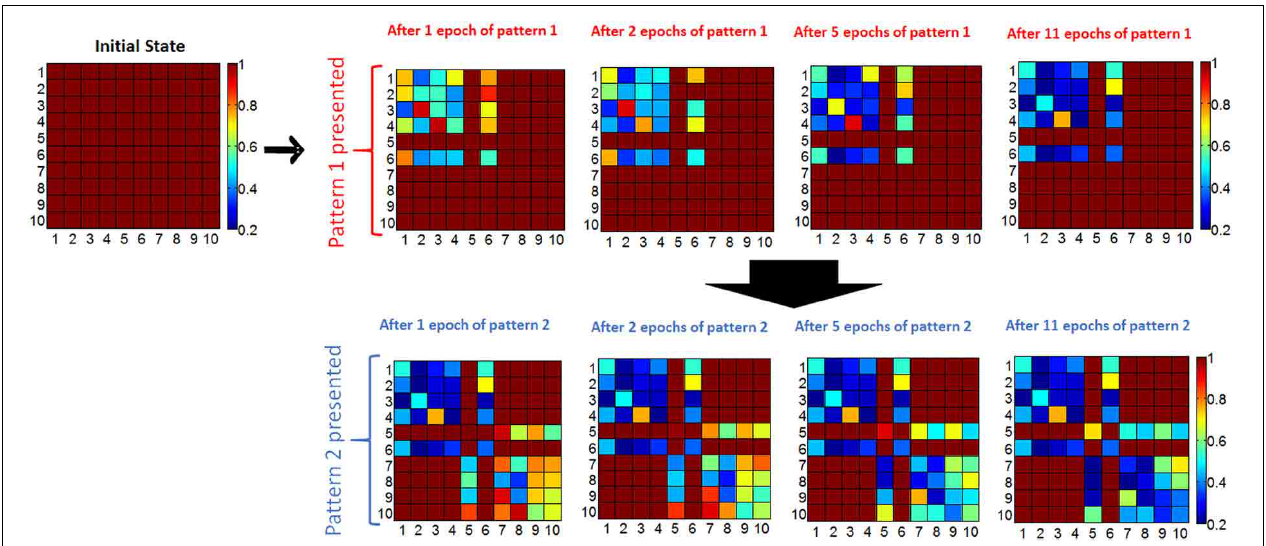
FIGURE 4 | Evolution of normalized resistance of synaptic devices is shown, for the 60% initial variation case. All normalized resistances are 1 initially since the normalized resistance map shows the current resistance of a synaptic device divided by its initial resistance. Note that the row and column numbers corresponds to BL and WL that connect the synaptic devices. For instance, the data shown in row #3 and column #6 is the normalized resistance of the memory cell that can be accessed by BL #6 and WL #3. First, pattern 1 is presented to the network. For pattern 1, ON neurons for the complete pattern during